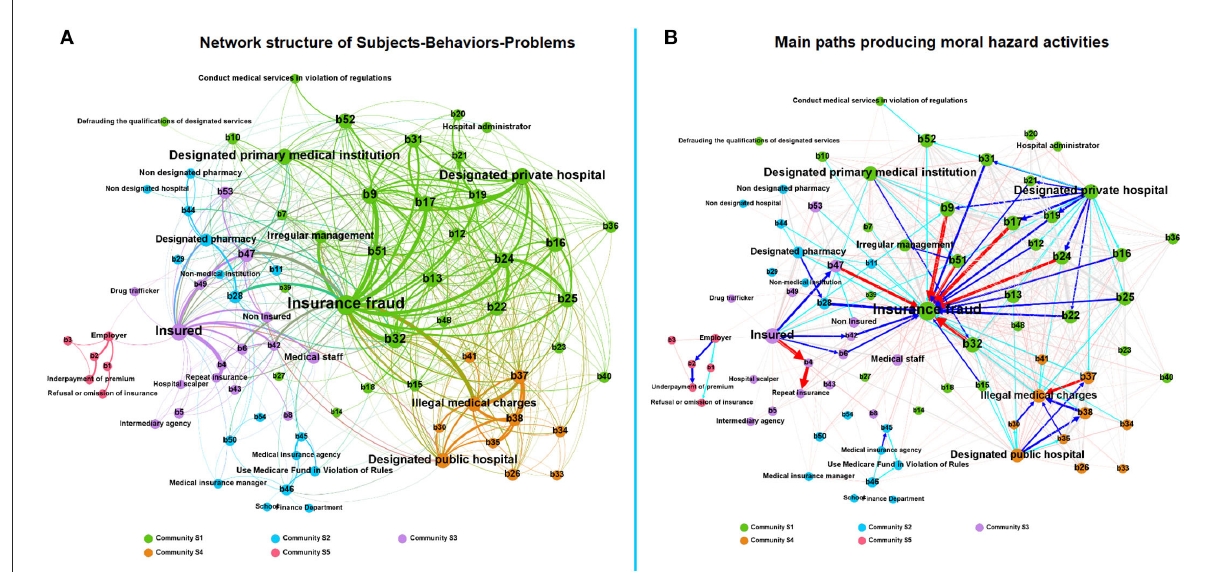
FIGURE4 (A) Network structure of subjects-behaviors-problems in medical insurance moral hazard; (B) Main paths producing moral hazard activities. The red arrow in (B) means that the edge weight is ≥ 20, the blue arrow means that the edge weight is between 10–20, and the green arrow means that the edge weight is between